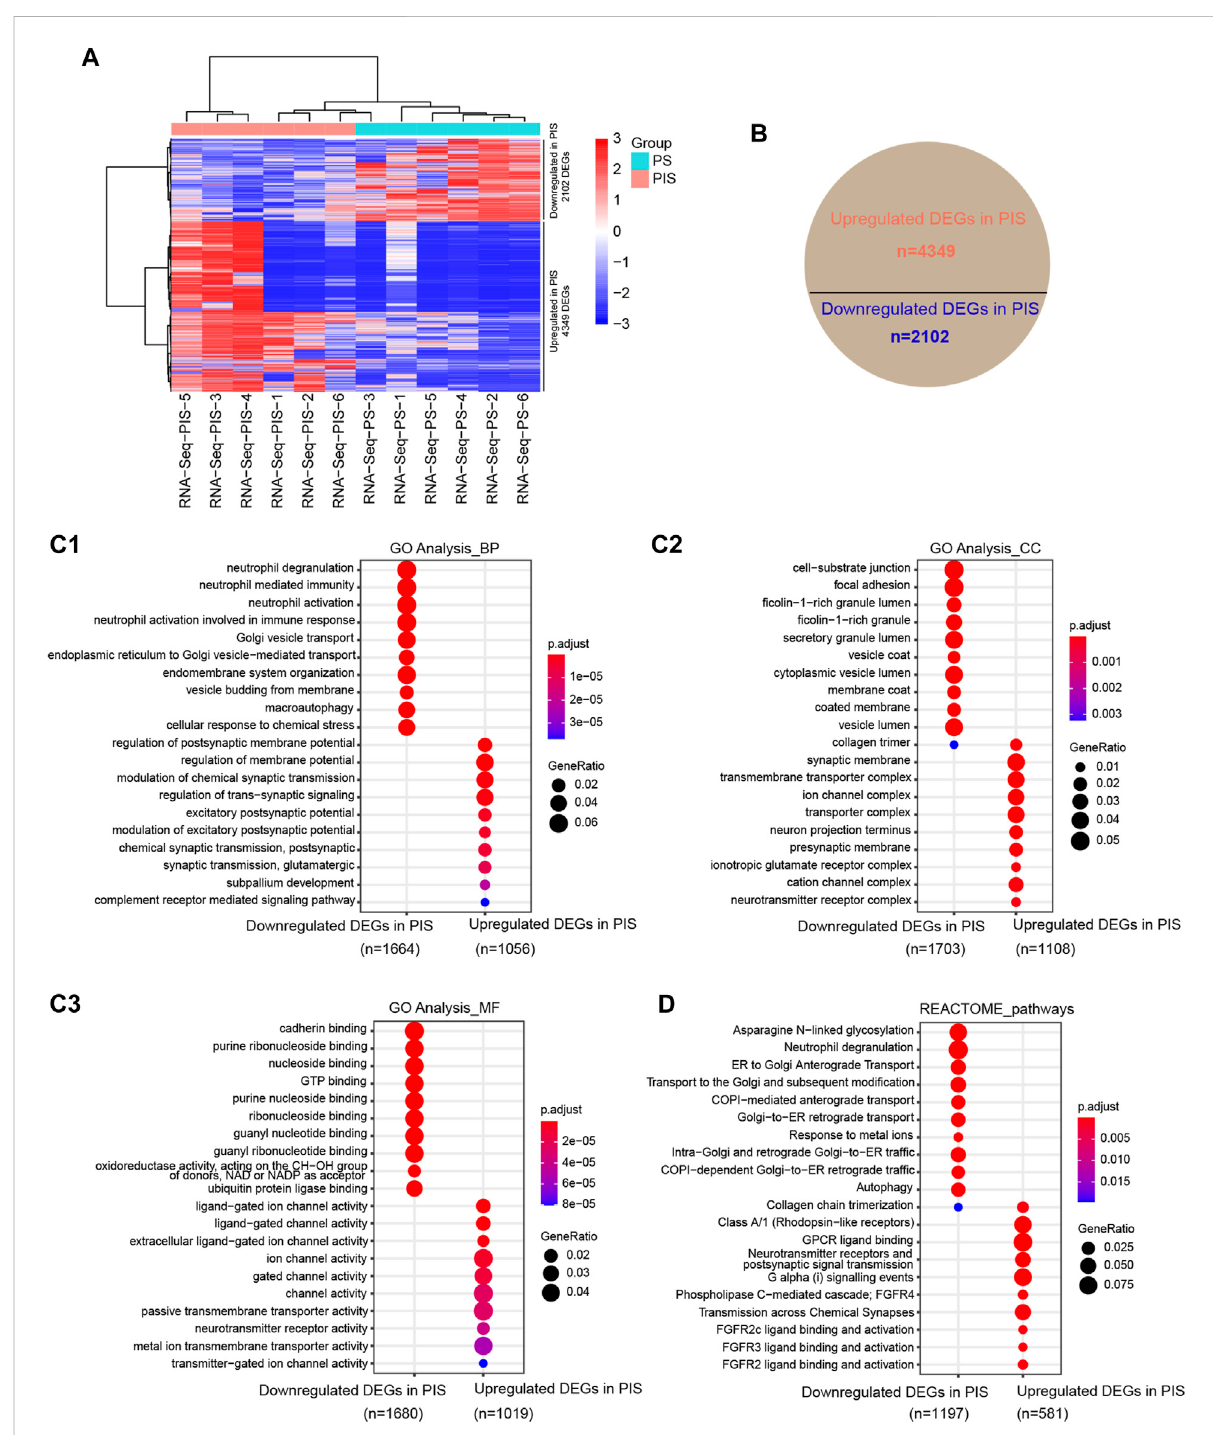
FIGURE 2 Expressionpro fi lesbyRNA-SeqinPISandPSpatientswithEAHandEEC. (A) HierarchicalclusteranalysisofallDEGsannotatedbyFPKMbyusing DESeq2normalization.Therowsrepresent the4349upregulatedand2102 downregulated genes.Redgridsrepresentupregulated geneswhileblue grids represent downregulated genes. (B) Statistical pie chart of upregulated and downregulated DEGs in the PIS group compared to the PS group. (C) BubblediagramoftheGOanalysisoftheupregulatedanddownregulatedDEGsinthePISgroupcomparedtothePSgroup,including BP ( C1 ), CC ( C2 ), and MF ( C3 ). The top ten clusters with adjusted p < 0.05 were shown. (D) REACTOME pathway annotation of upregulated and downregulated DEGs inthePIS group compared to the PS group. The top ten enriched pathways with adjusted p < 0.05 were shown. Abbreviations: PIS, progestin insensitive; PS, progestin sensitive; DEGs, differentially expressed genes; GO, Gene Ontology; BP, biological process; CC, cellular components; MF, molecular